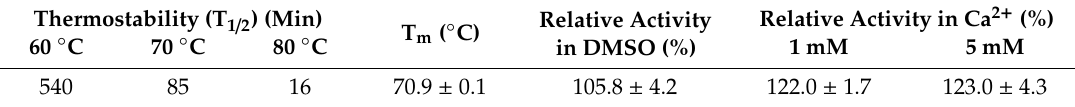
Table 5. Characteristics of wt-HT1 lipase